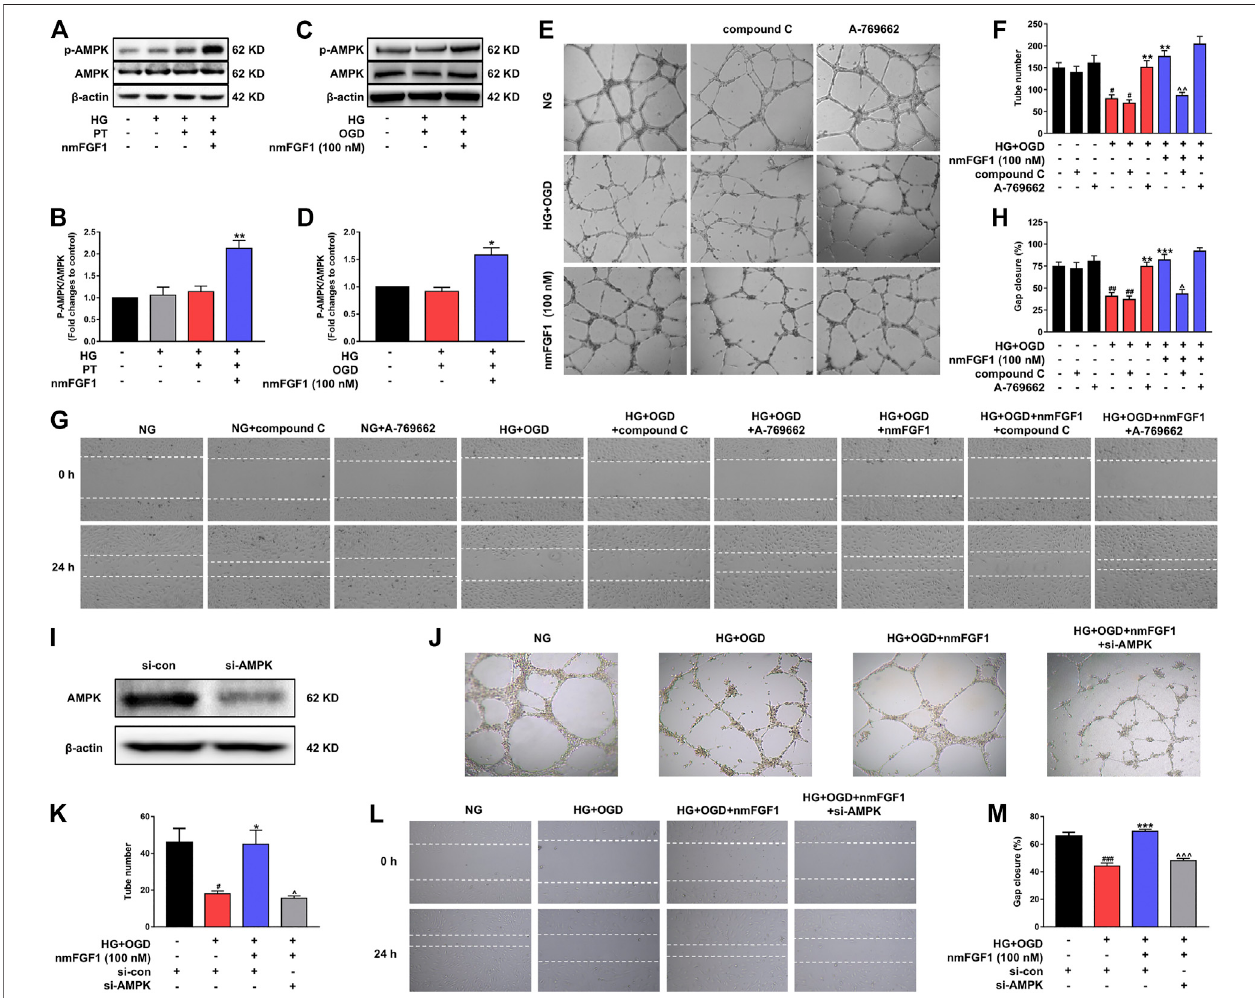
FIGURE 5 | NmFGF1 promoted tube formation and migration of HBMEC in HG + OGD-treated HBMEC cells by activating the AMPK signaling pathway. (A) Western blotting analysis of p -AMPK and AMPK levels in a mouse model of diabetic stroke treated with or without nmFGF1. β -actin was used as a loading control. (B) The ratio of p -AMPK/AMPK. (C) The levels of p -AMPK and AMPK in HBMEC cells, as determined by western blotting. (D) The ratio of p -AMPK/AMPK in HBMECs, as quanti fi ed by image software. (E) Cells treated with an AMPK agonist or inhibitor. AMPK agonist, A-769662, 10 nM; AMPK inhibitor, compound C, 5 μ M. Tube formation was observed by phase contrast microscopy, original magni fi cation: × 40. (F) The number of tubes formed in HBMECs treated with an AMPK agonist or inhibitor. (G) The migration ability of HG + OGD-cultured HBMECs treated with an AMPK agonist or inhibitor. Images of the wound areas were observed by phase- contrast microscopy. A-769662, 10 nM, compound C, 5 μ M; Original magni fi cation: × 40. (H) The migration ratio was calculated using Image Pro Plus software. (I) AMPK expression wassilenced by the transfection of siRNA. (J) The effect ofAMPK silencing on tube formation. Original magni fi cation: × 40. (K) Quantitative analysisof tube formation. (L) Wounding healing migration assays of cells in which AMPK had been silenced by siRNA. Original magni fi cation: × 40. (M) Quantitative analysis of migrationratio(n (cid:2) 3).Dataare presented asmeans ± SEM. # p < 0.05, ## p < 0.01, ### p < 0.001vs. NGgroup;* p < 0.05, ** p < 0.01, *** p < 0.001 vs.HG+OGDorHG+ PT group; ^ p < 0.05, ^^ p < 0.01, ^^^ p < 0.001 vs. HG + OGD + nmFGF1